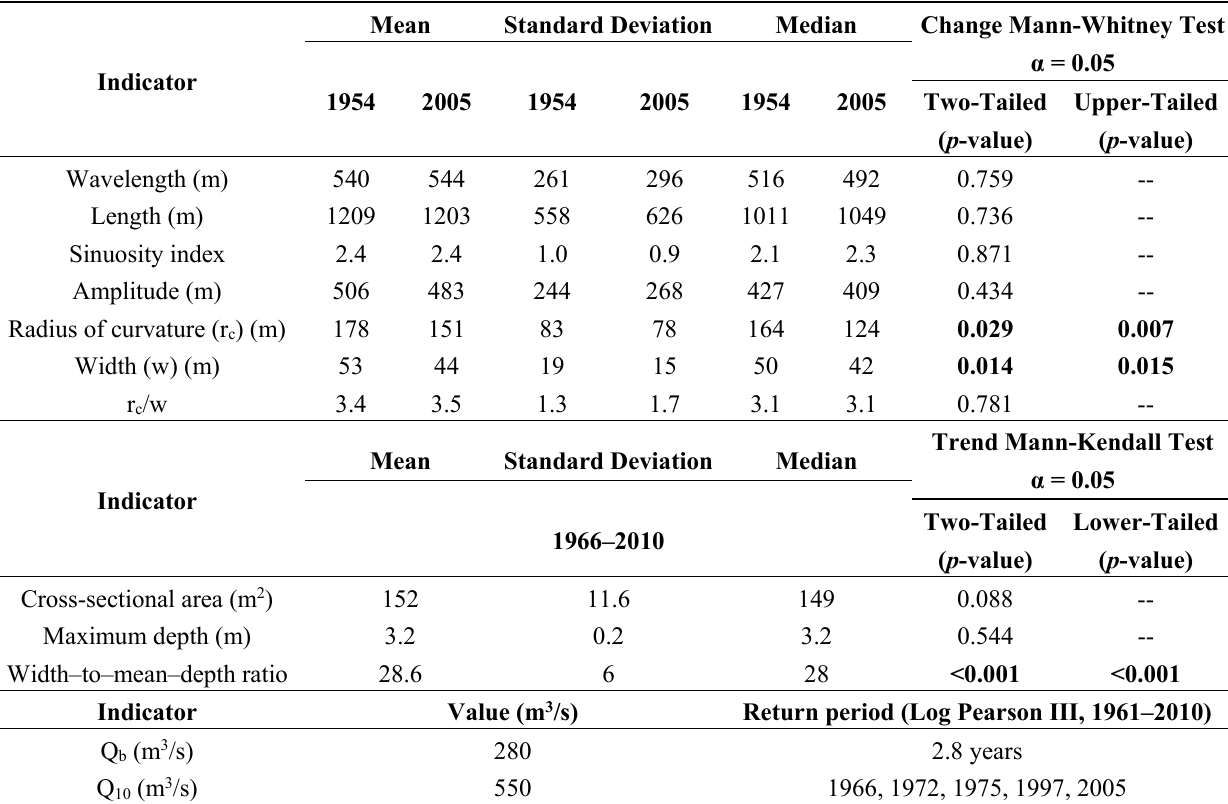
Table 1. Alteration indicators of the Lower Prahova River (statistically significant changes/trends in